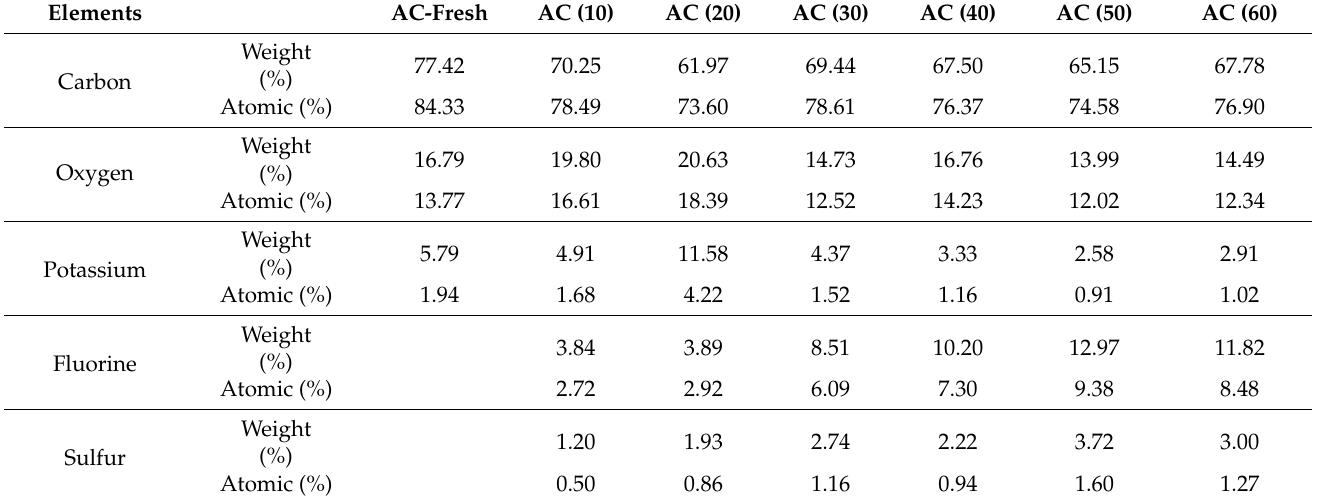
Table 1. Elemental composition of RSS derived activated carbon